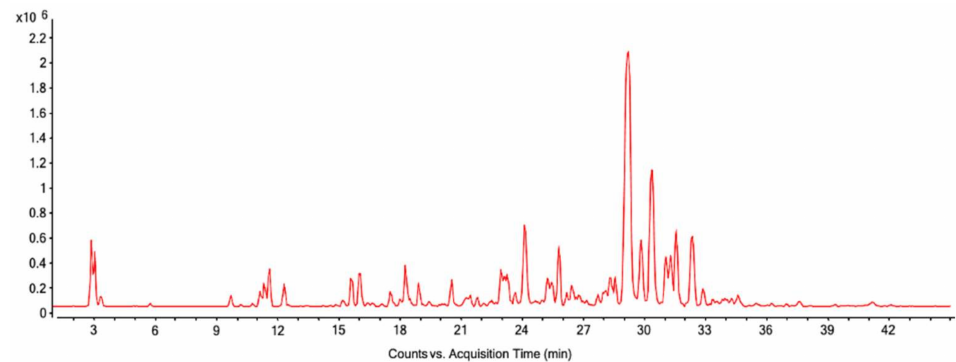
Figure 2. Base peak chromatogram obtained by analysis of the OELE by LC-MS/MS.